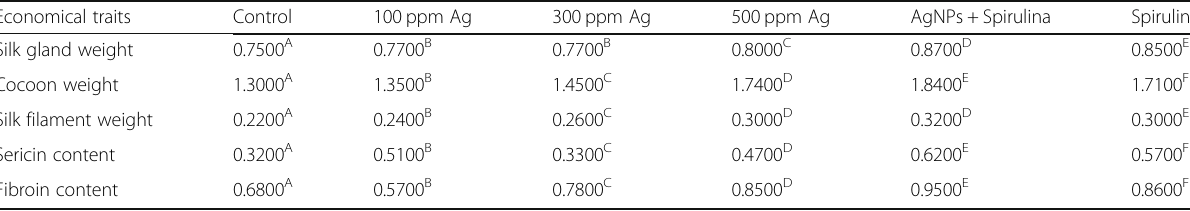
Table 4 DMRT analysis of silkworm Bombyx mori on economical traits Economical